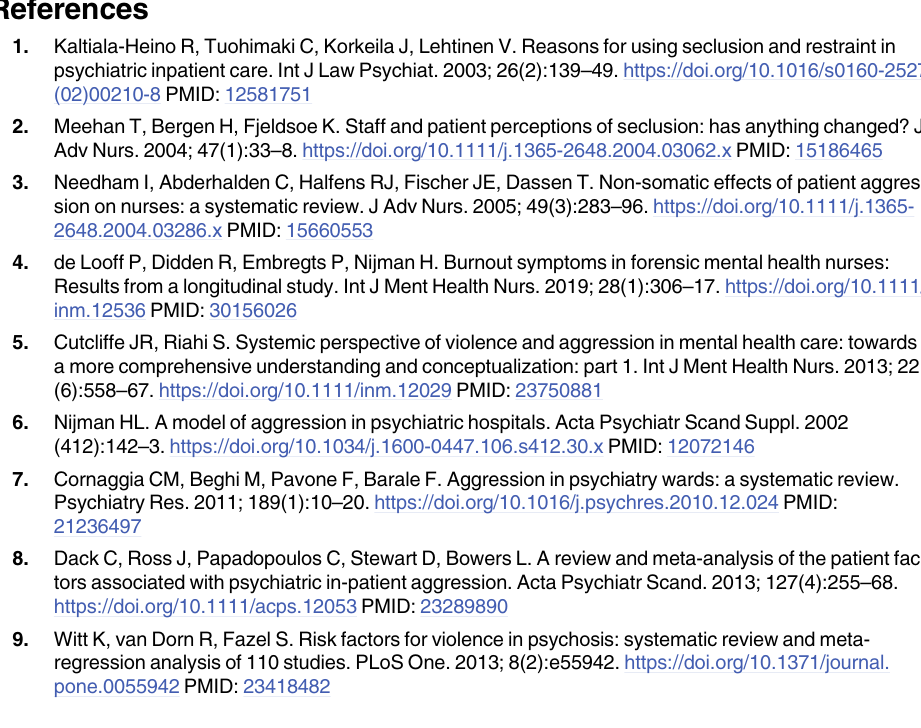
S2 Table. Included studies on prevalence of aggression measured in patient